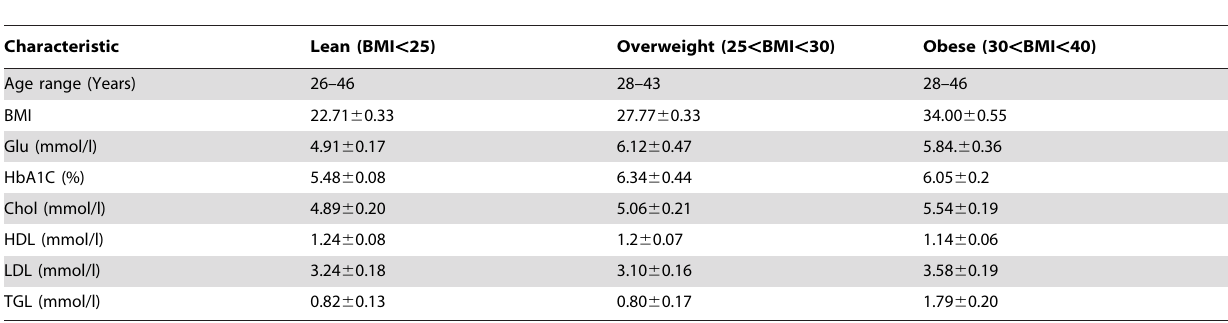
Table 1. Characteristics of the study